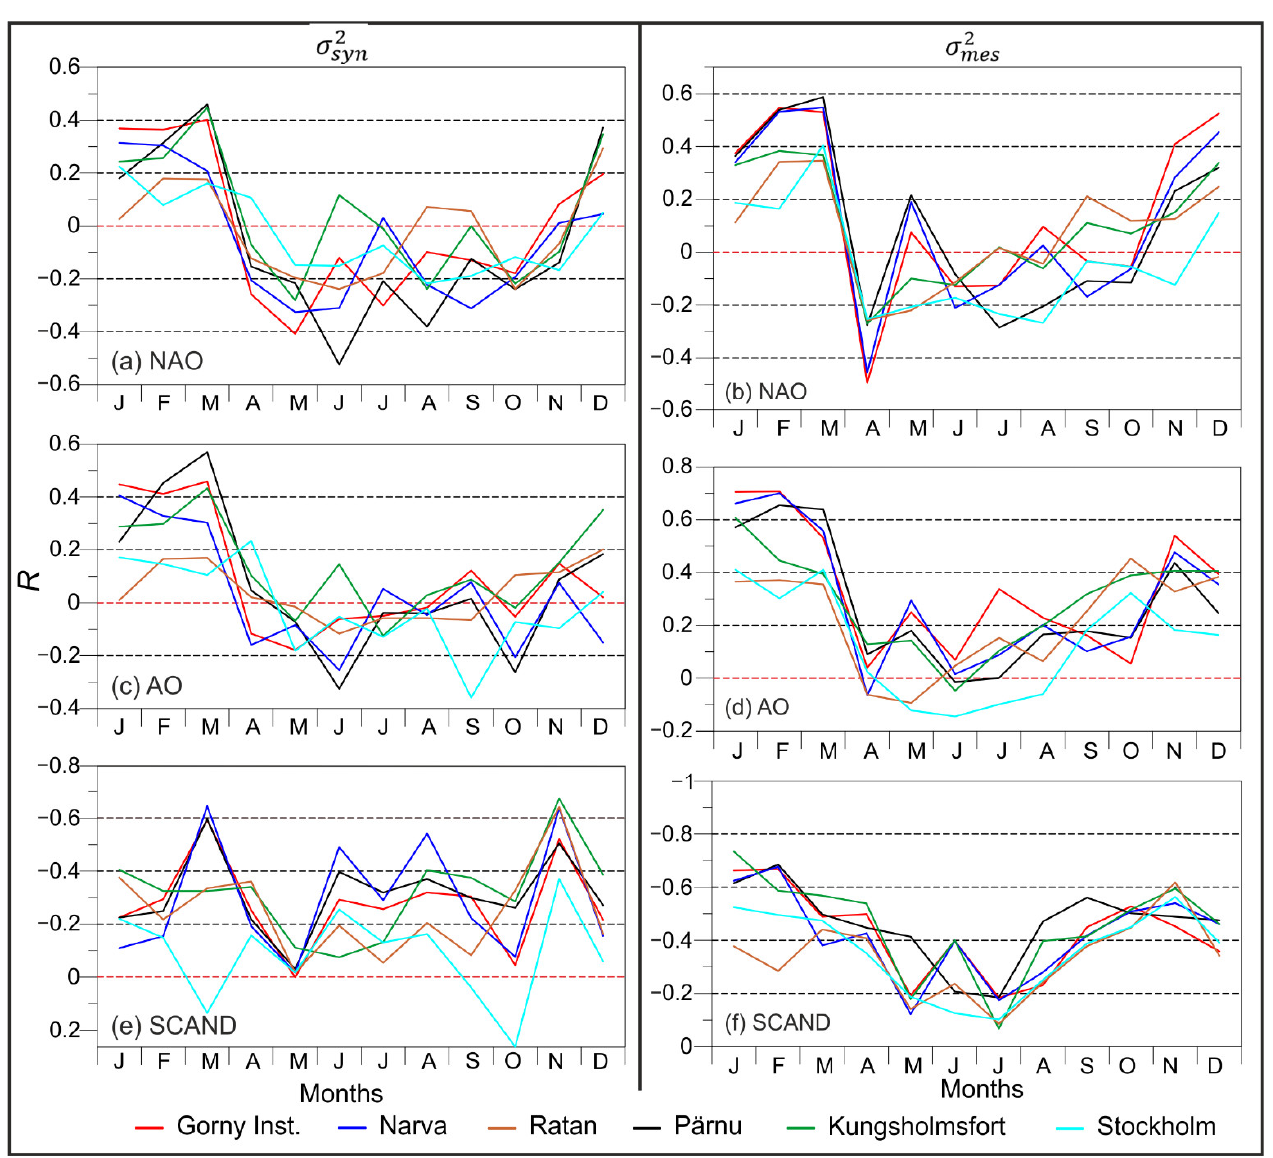
Figure 6. Correlation coefficient (R) of the variance of ( a , c , e ) synoptic and ( b , d , f ) mesoscale sea level oscillations and ( a , b ) NAO, ( c , d ) AO, and ( e , f ) SCAND indices.